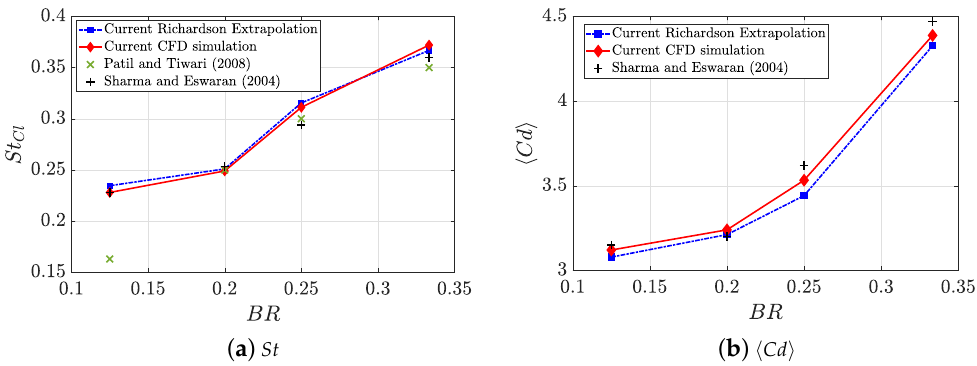
Figure 2. Validation of the CFD simulation with data from the literature: Patil and Tiwari (2008) [38] and Sharma and Eswaram (2004) [26]. The geometric configurations are confined flows around a square pillar ( AR = 1) and a fully developed flow at Re = 100.